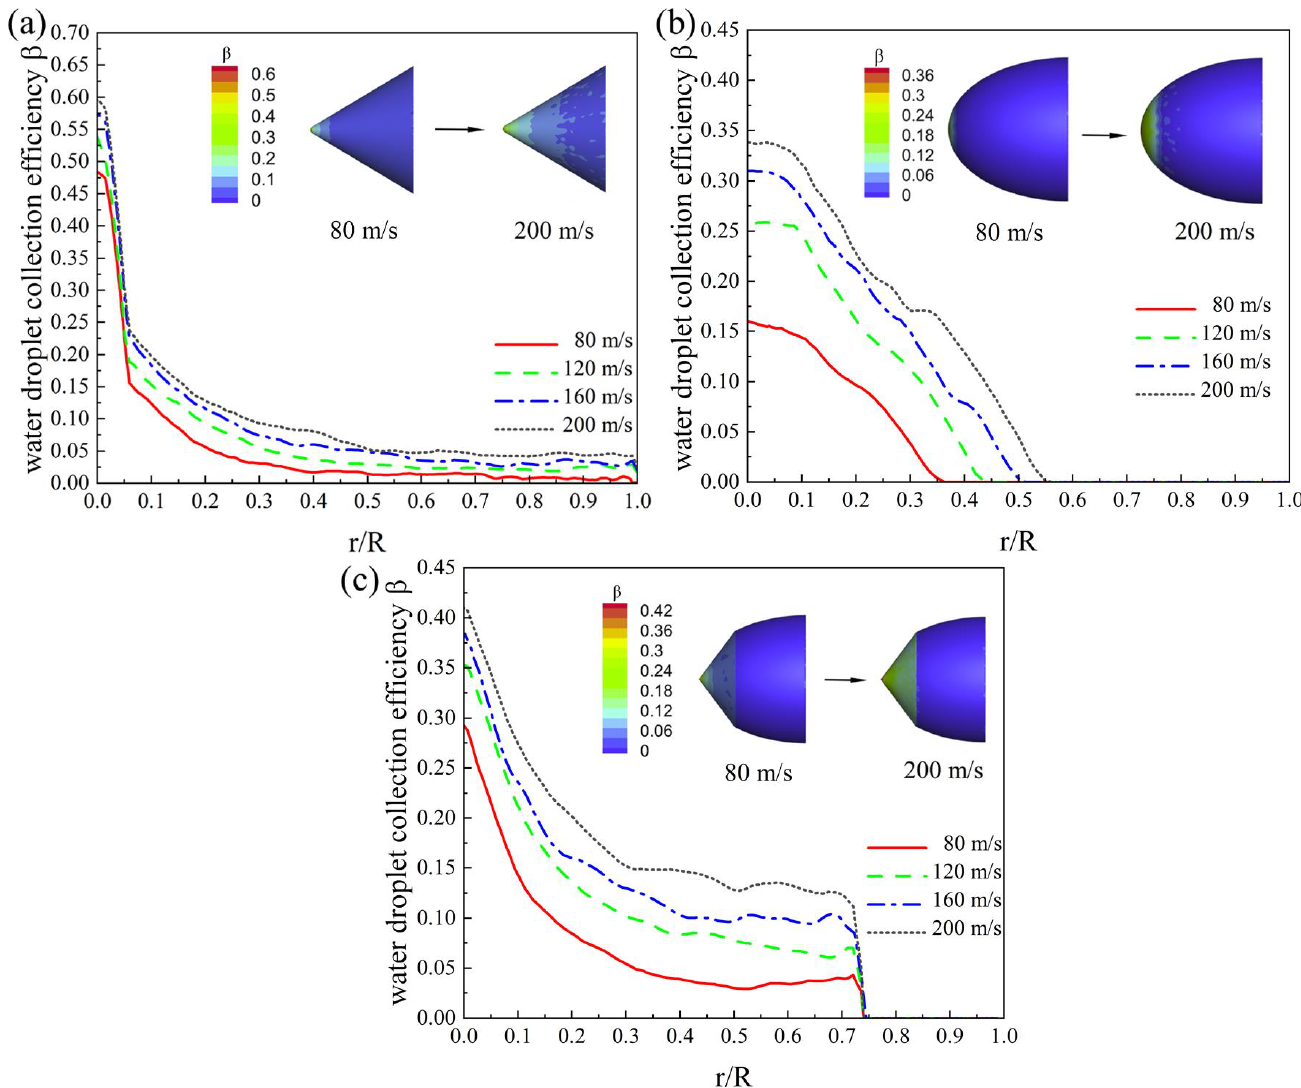
Figure 13. Influence of inflow velocity on water droplet collection efficiency with varied spinner shapes: ( a ) conical spinner; ( b ) elliptical spinner; ( c ) coniptical spinner.